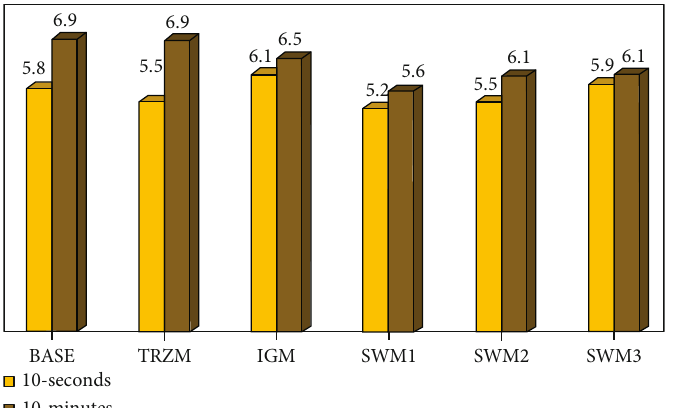
Figure 4: Gel strengths of the prepared mud samples.